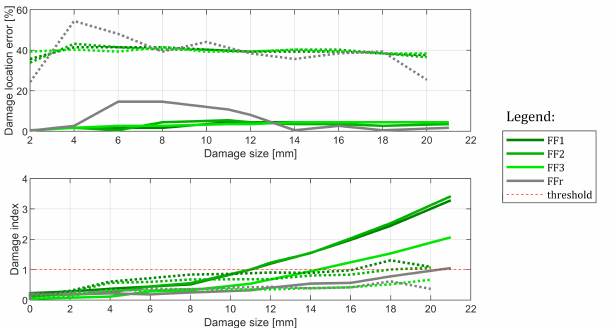
Figure 20. The results obtained for cases C#1 and C#3, that is for the same camera and specimen, but for two different damage locations. Damage location 2 is marked in dashed lines.